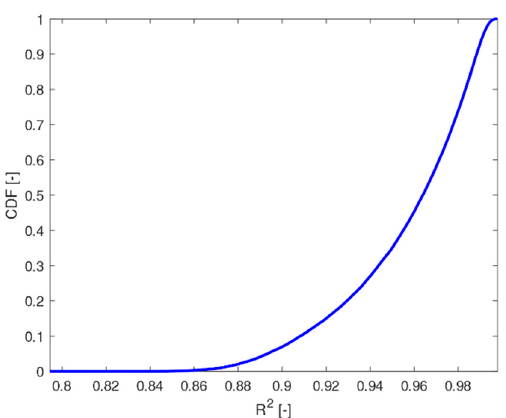
Figure 5. Cumulative distribution frequency of R 2 of a sample of 50,000 random generated basins. The coefficient of determination describes the goodness of Fu’s equation in describing water partitioning over wide range of aridity indices.